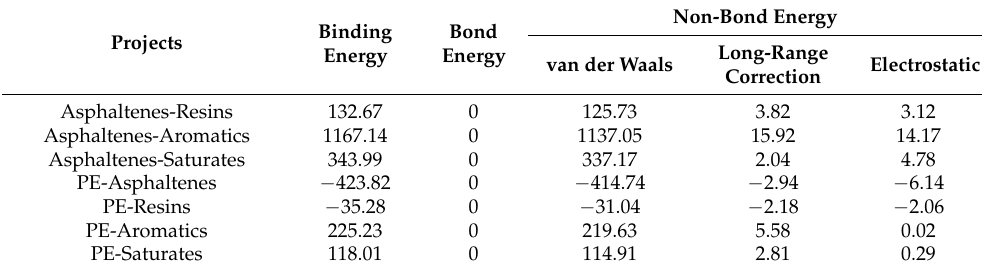
Table 4. Binding energy between components in RPE-modified asphalt.